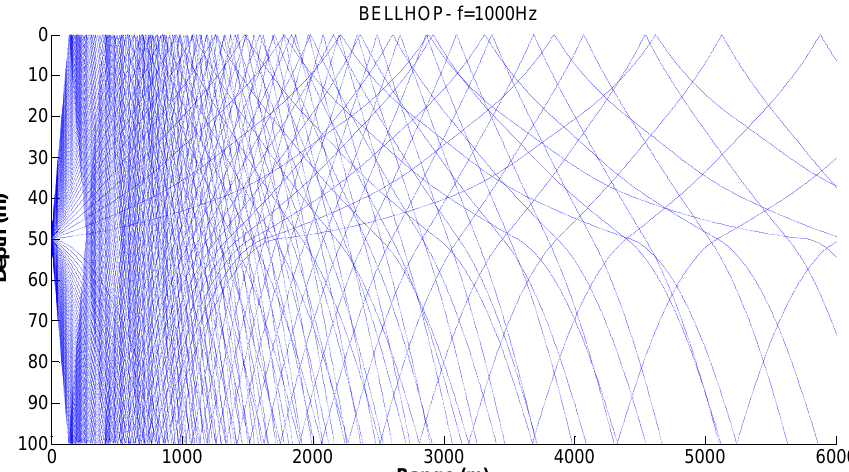
Figure 9. Corresponding ray trace for a source depth of 50